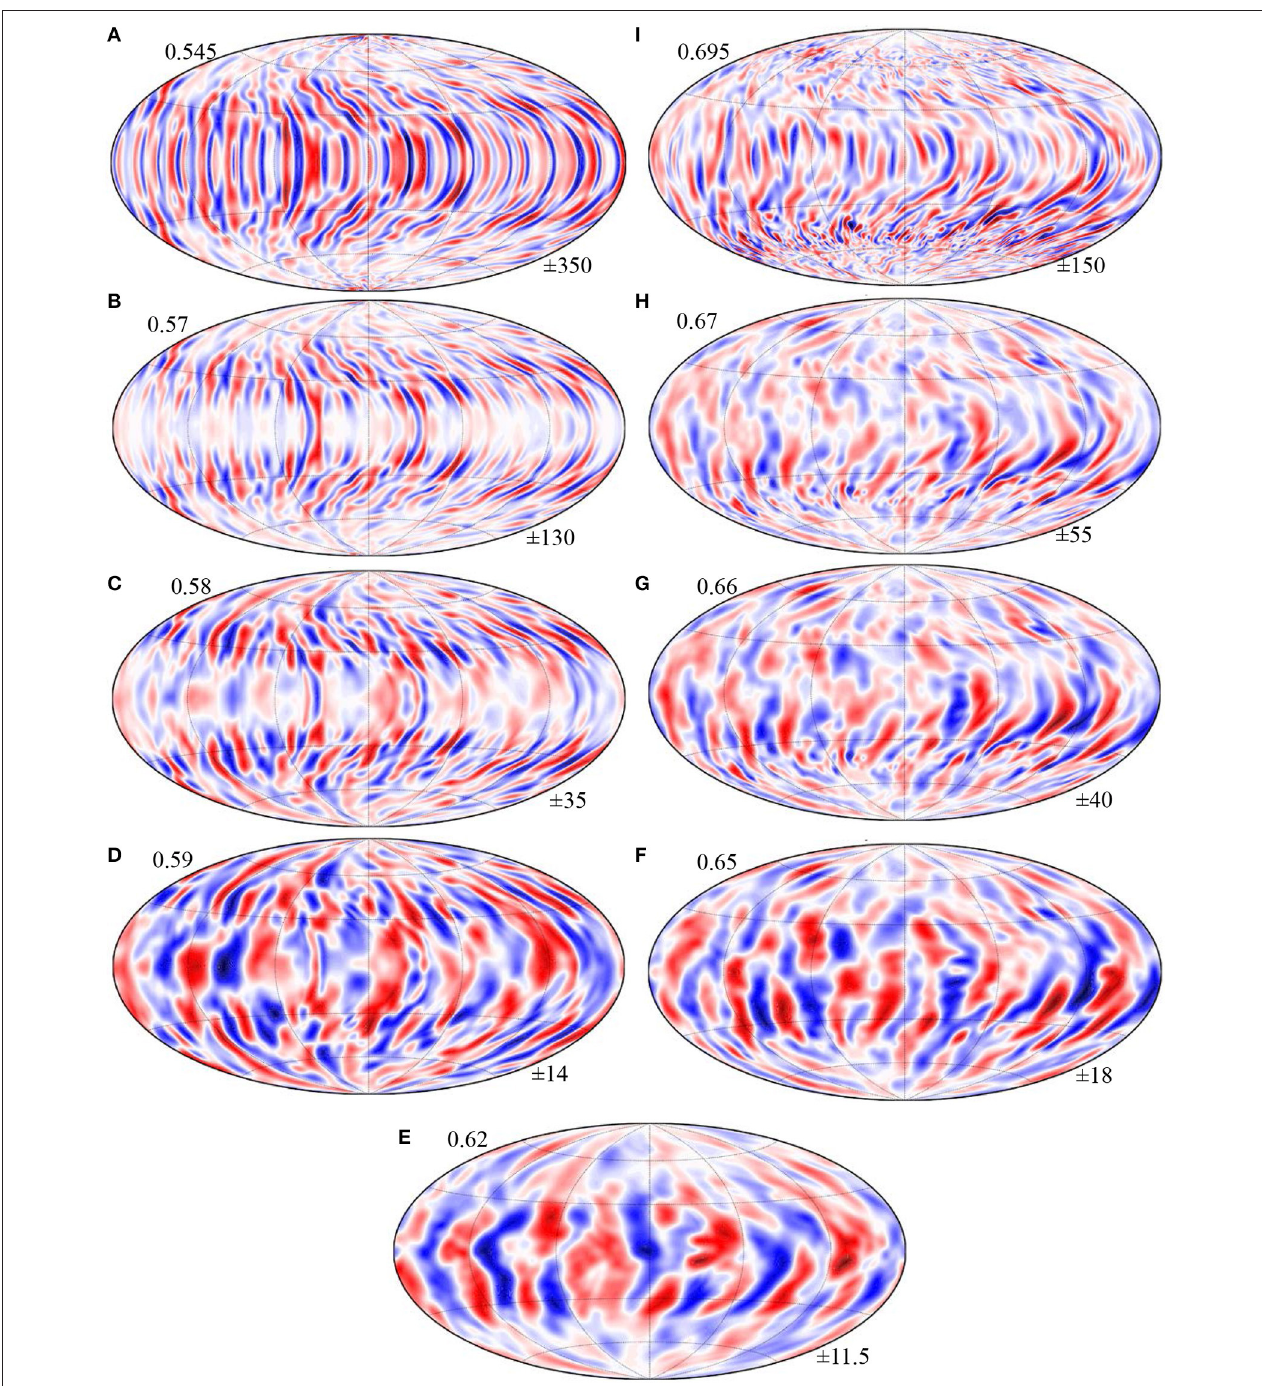
FIGURE 5 | Instantaneous radial flow on spherical surfaces taken at various radii indicated at the top left of each panel, ranging from r the SSL at r 0.62 (E) to r 0.695 (I) . The min/max velocity contour is indicated at the lower right. The velocity scale is the Reynolds-number. Parameters: model = = 4.10 from Table 1 , I s 0.746, Ro c 0.245. = =